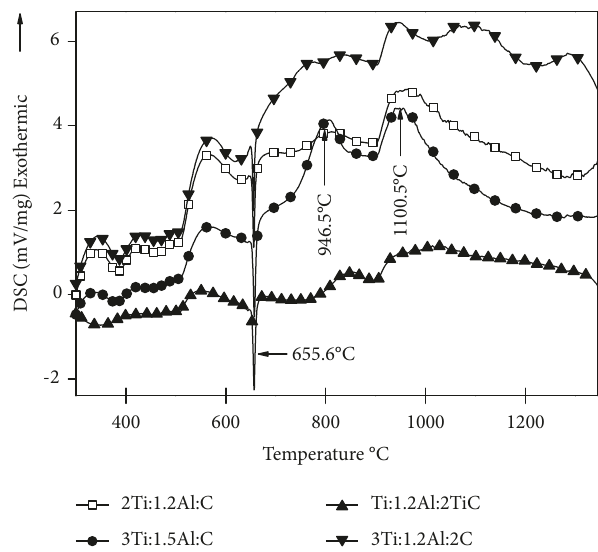
Figure 1: DTA curves of four kinds of starting